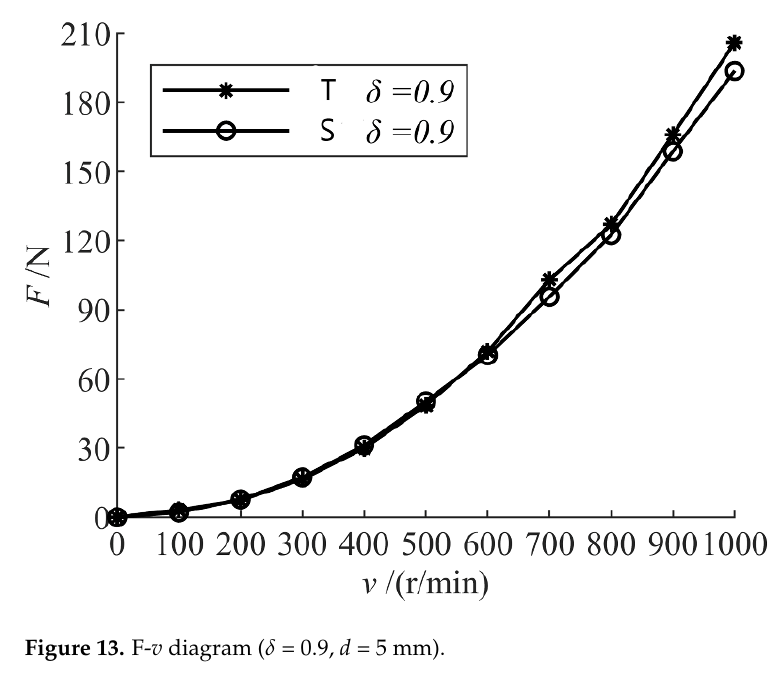
Figure 13. F- v diagram ( δ = 0.9, d = 5 mm).